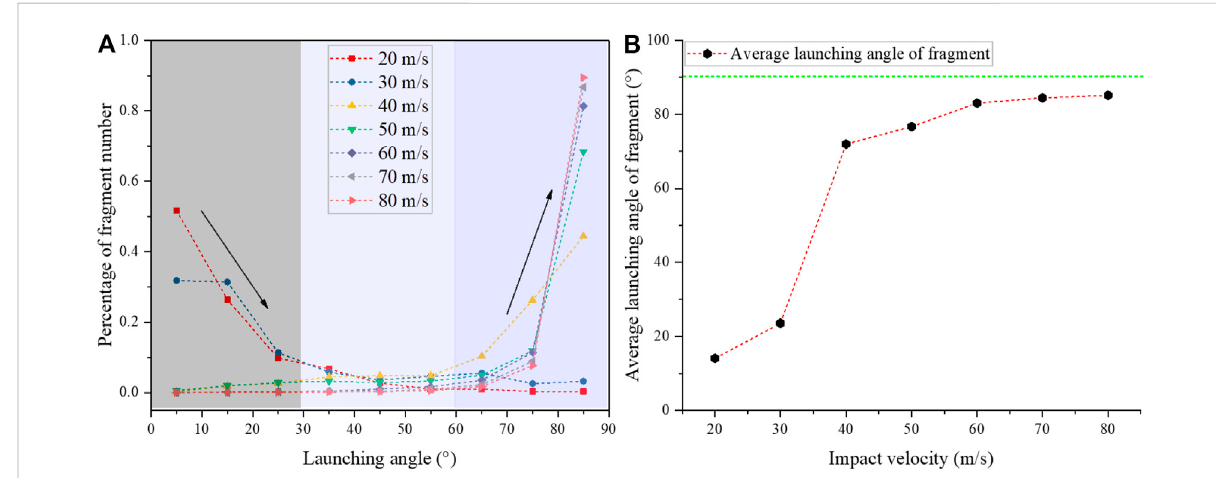
FIGURE 15 (A) The distribution of fragment fl ying angle at different impact velocities (different color areas represent different variation intervals, and the black arrows show the decreasing or increasing trends); (B) the average fl ying angle of fragments under different impact